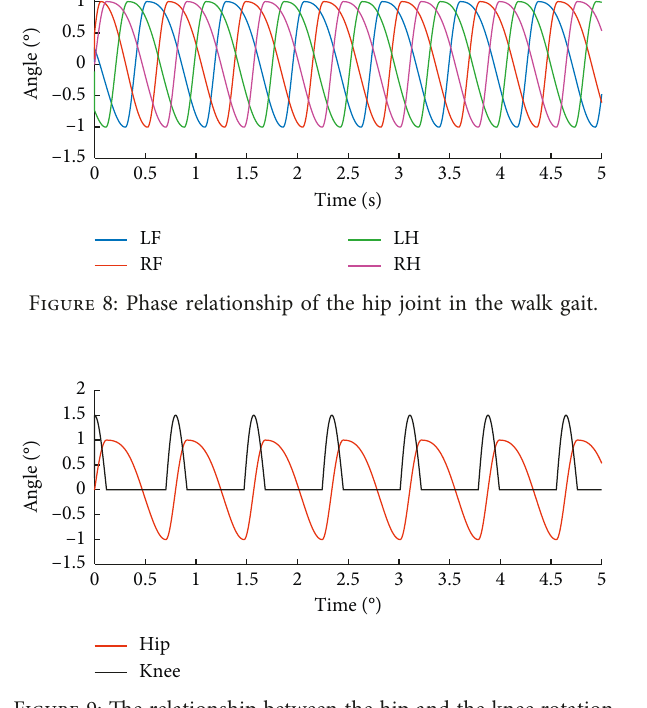
Figure 13: Control curve of the hip and the knee joint of LF.